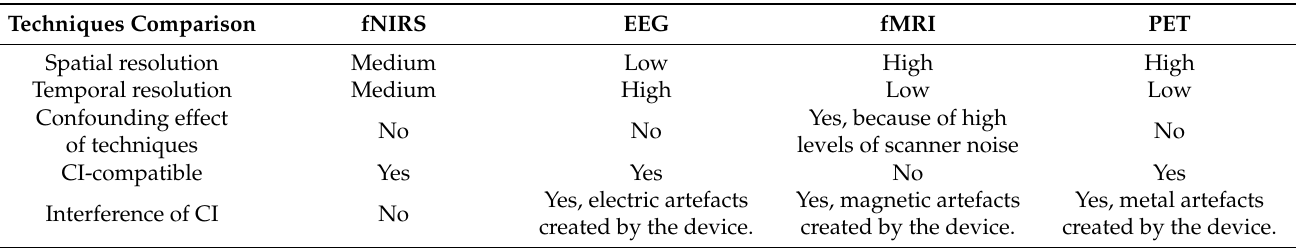
Table 2. Comparison between fNIRS and other